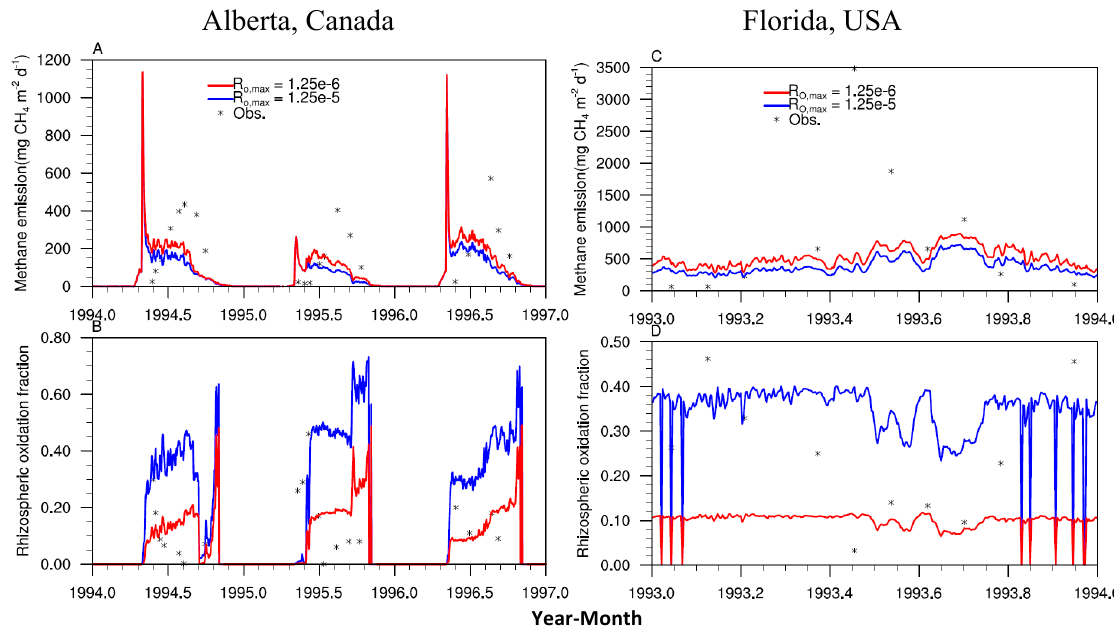
Fig. 7. Comparisons between model simulations and observation at Alberta (Canada) and Florida (USA) sites. For each site, the top figure shows comparison of methane emissions with different R o, max values; the bottom figure shows the comparison of estimated rhizospheric oxidation fraction with different R o, max with